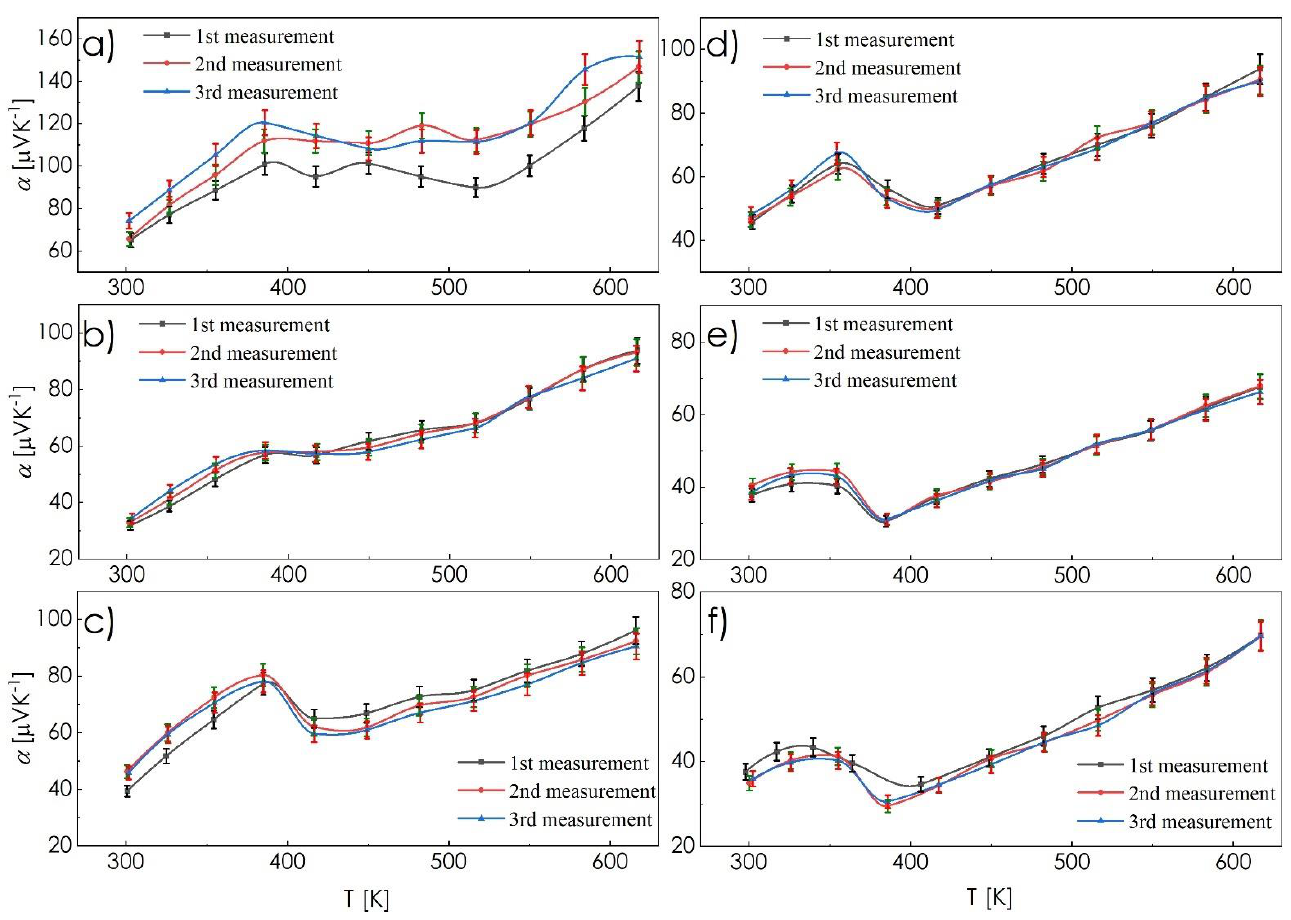
Figure 6. Cyclic measurements of the Seebeck coefficient as a function of temperature recorded for composite ingots: ( a ) CSS1, ( b ) CSS5, ( c ) CSS10, ( d ) CSE1, ( e ) CSE5, ( f ) CSE10.